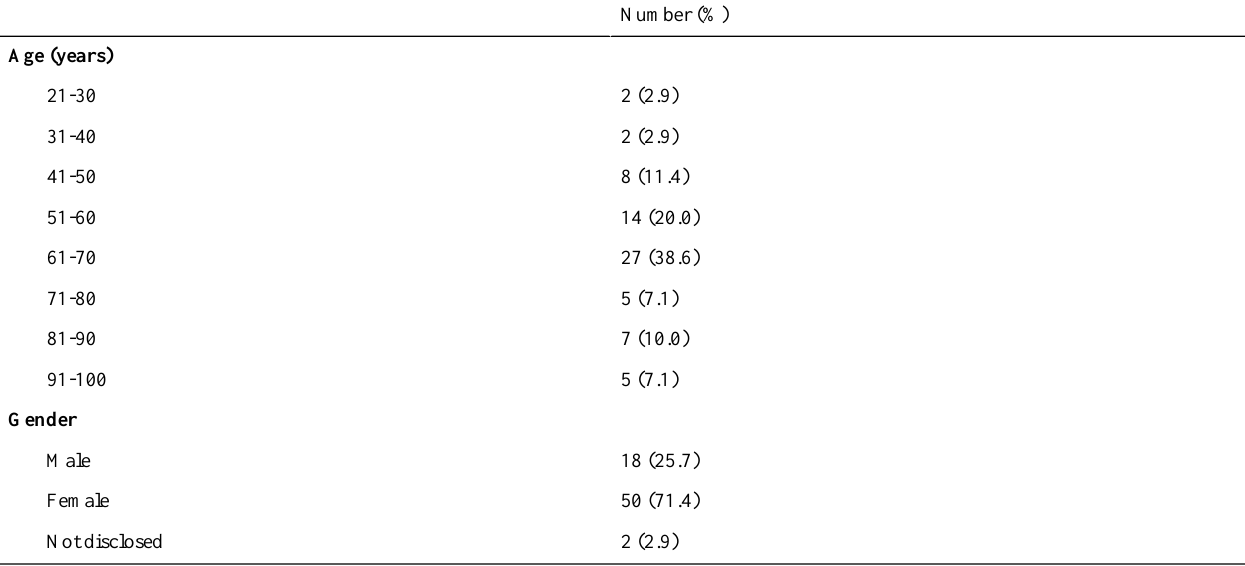
Table 1. Age and gender distribution of PHIMS users (N =